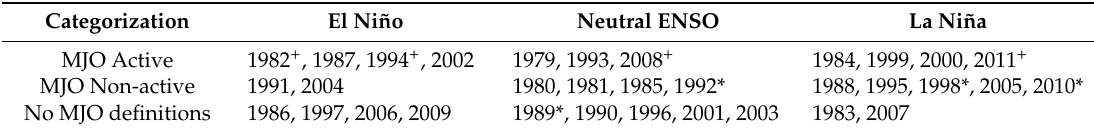
Table 1. Categorization of years during the period from 1979 to 2011 into Madden–Julian Oscillation (MJO) active year, MJO non-active year, no MJO definition year, El Niño year, neutral ENSO year, and La Niña